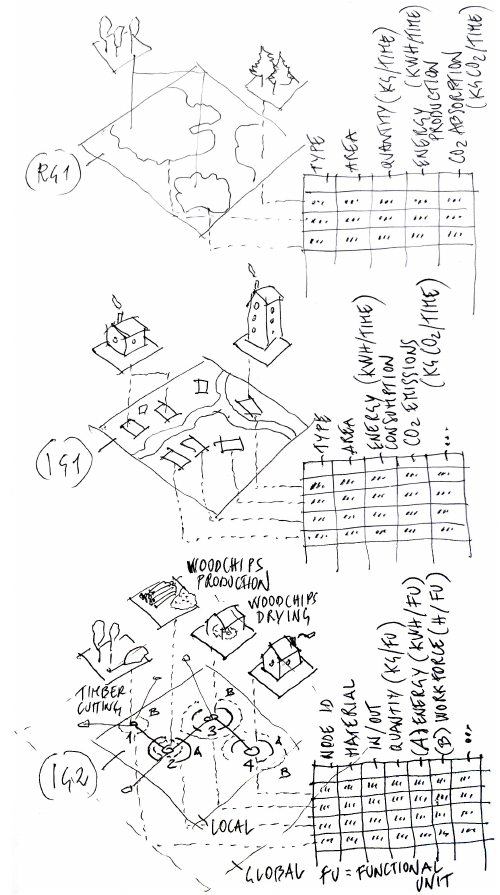
Figure 6. Some of the Geographies presented in order to verify compliance